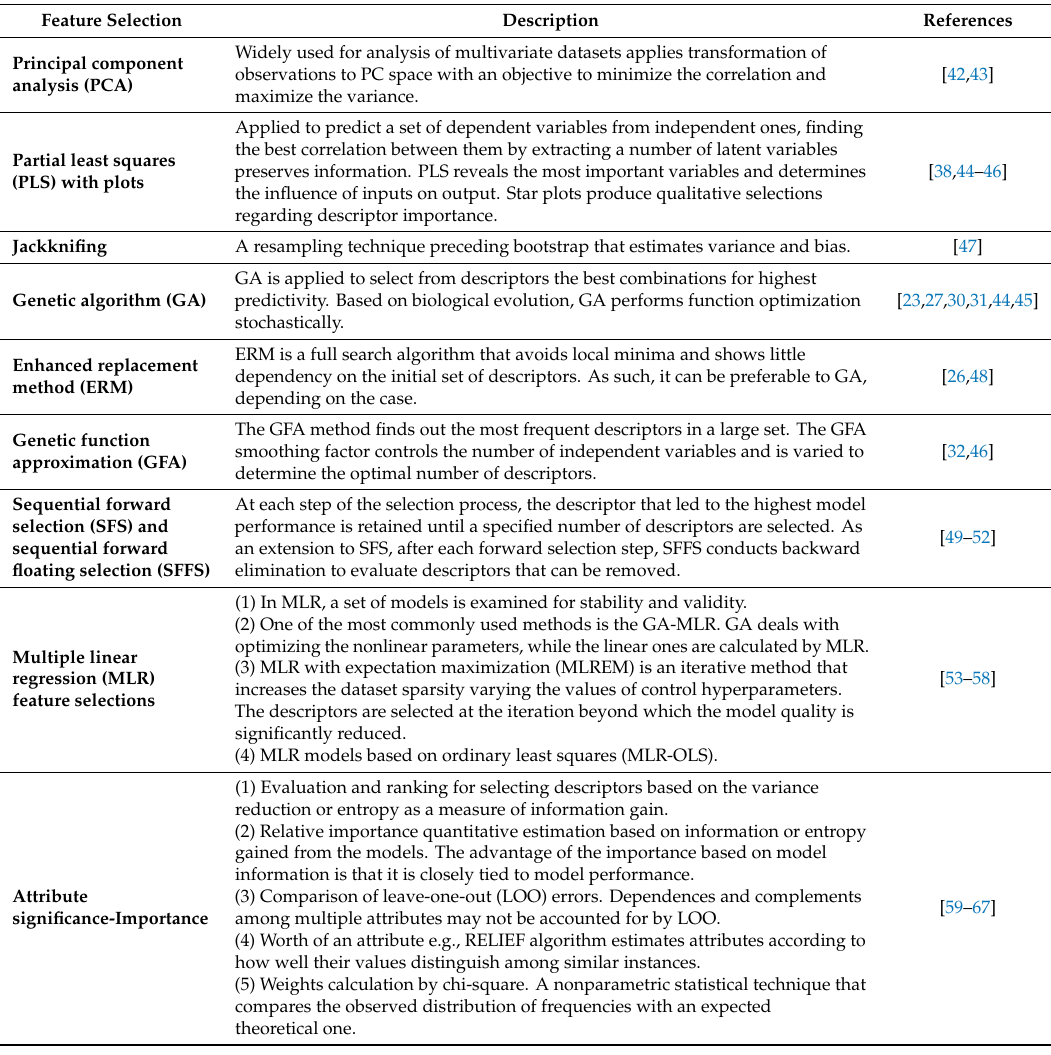
Table 2. An overview of selection techniques used in the reviewed